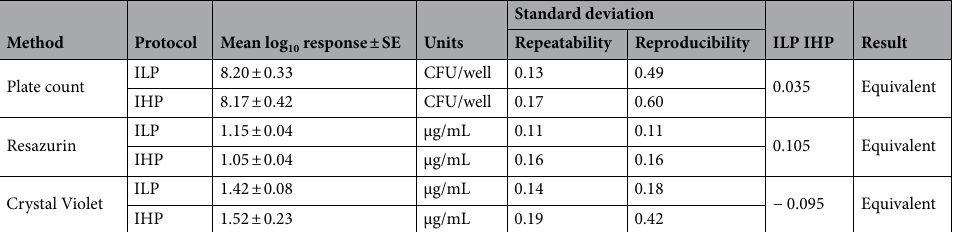
Table 2. Comparison of the ILP and IHP control data for each method. The table shows the main conclusions (mean Log 10 values ± Standard Error (SE), and standard deviations for repeatability and reproducibility, difference between means, and equivalency testing at 97.5% confidence with an equivalency margin of 0.5 logs) for the control experiments data using the ILP and IHP protocols.